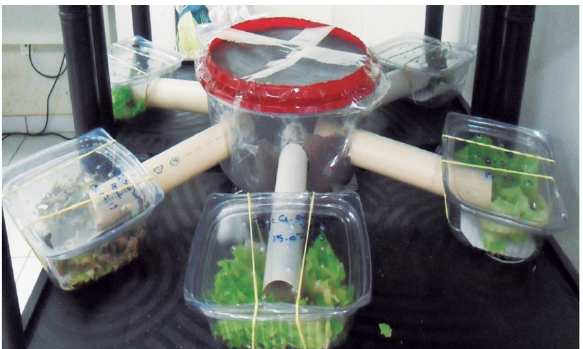
Figure 1. Olfactometer model used in